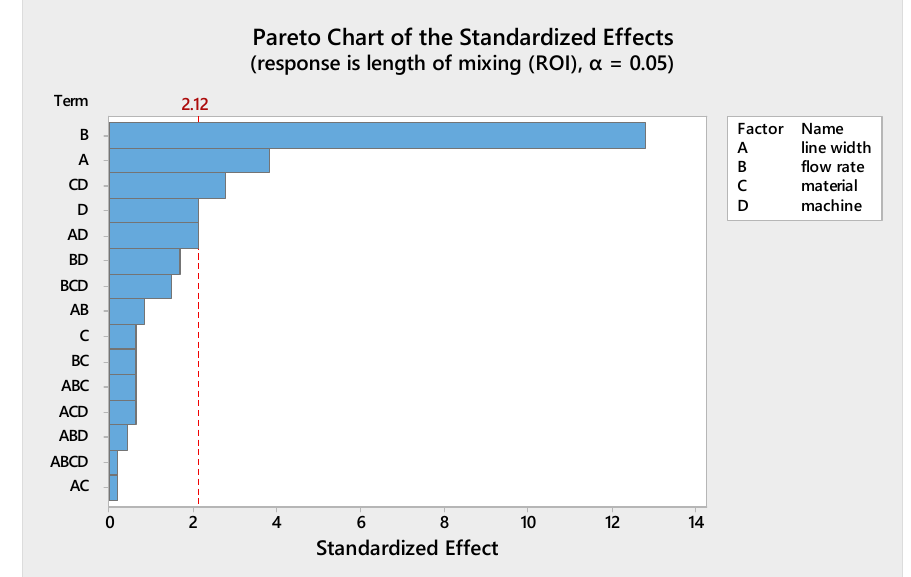
Figure 6. Pareto chart of standardized effects.